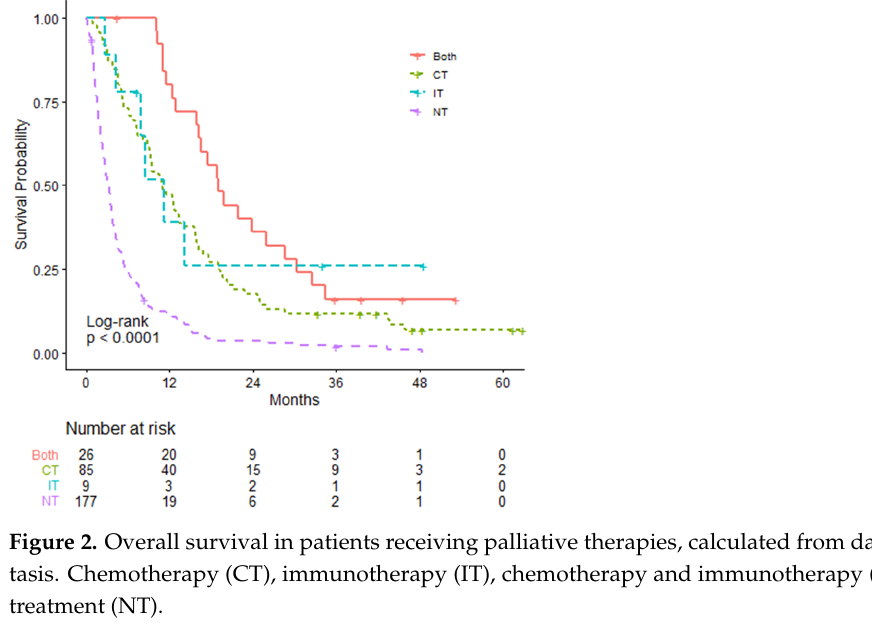
Figure 3. Overall survival in patients receiving first-line palliative therapies. ( a ) OS calculated from date of metastasis. ( b ) OS calculated from initiation of first-line therapy. Chemotherapy (1L CT), immunotherapy (1L IT) or no treatment (1L NT).